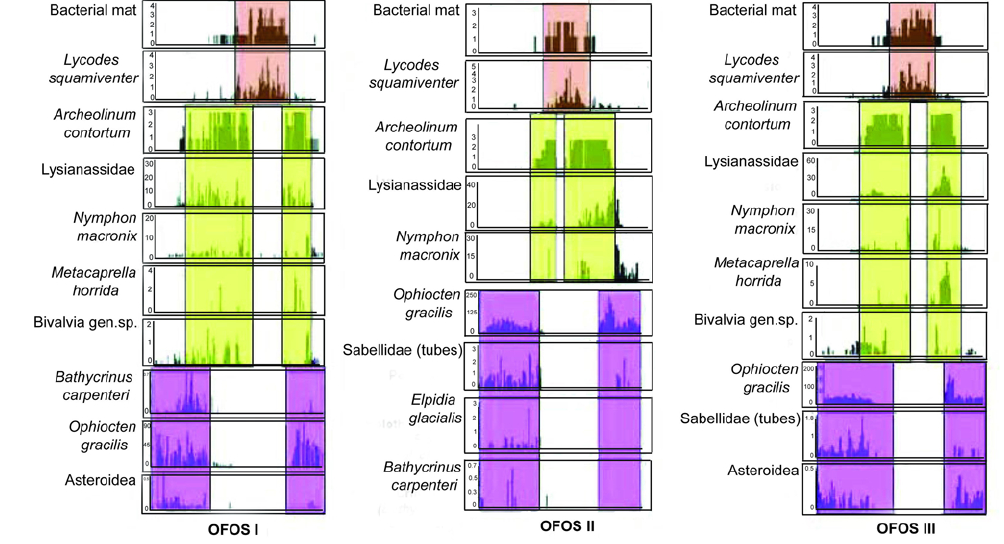
Fig. 8. Variations in mean densities of selected taxa and area coverage of bacterial mats or siboglinids on images along OFOS transects I, II and III. Density in ind.m − 2 on the left axis. Area coverage: Bacterial mats: 0 – 0%, 1 – < 10%, 2 – 10–50%, 3 – 50–80%, 4 – > 80%; Archeolinum contortum : 0 – 0%, 1 – < 10%, 2 – 10–50%, 3 – > 50%. Zones are shown in colour: red – bacterial mats, yellow – siboglinid settlements, violet – plain light-coloured sediment.